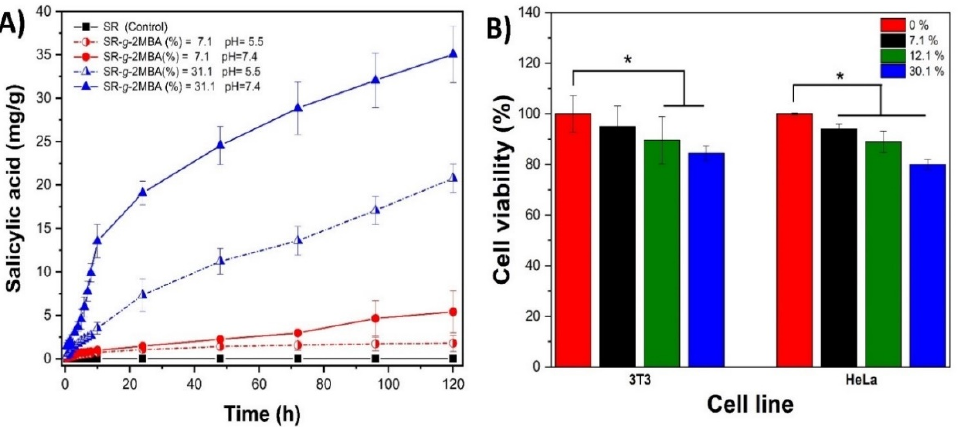
Figure 5. Release profile of salicylic acid from ( A ) SR- g -2MBA and viability of HeLa and BALB / 3T3 cells after 24 h ( B ). The graphs represent the mean and standard deviation from three independent experiments, while the asterisk indicates statistical significance ( p < 0.05).